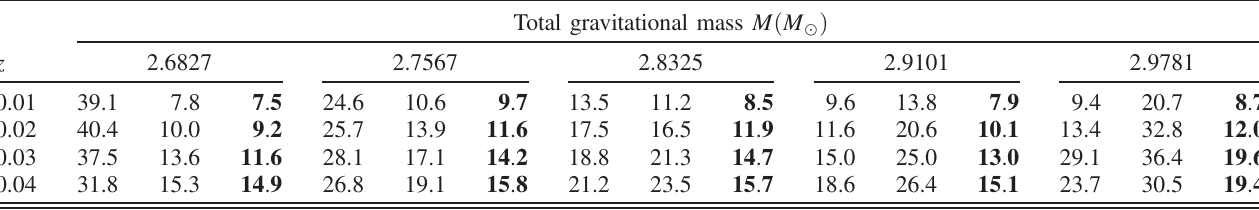
TABLE IV. The percentage measurement uncertainties on the redshift of a BNS source. We show results for each of our five different mass systems and for each of four different redshifts. We give three fractional redshift uncertainties for each combination. The first and second entries correspond to results using the inspiral measurement plus the first and second spectral features, respectively. The third result (in bold face) is from a combination of the inspiral measurement and both spectral features. We have performed analyses of 100 different noise realizations, source, and sky orientations for each redshift and mass combination. For each realization, we compute a quantity equal to half of the span of the 68% confidence region on the redshift measurement. The quoted value is the median of this quantity over the 100